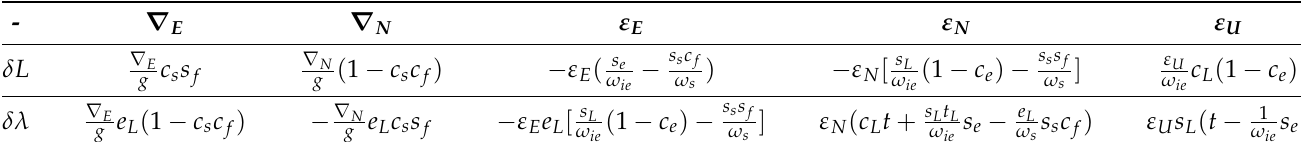
Table 1. Long-term navigation error propagation.